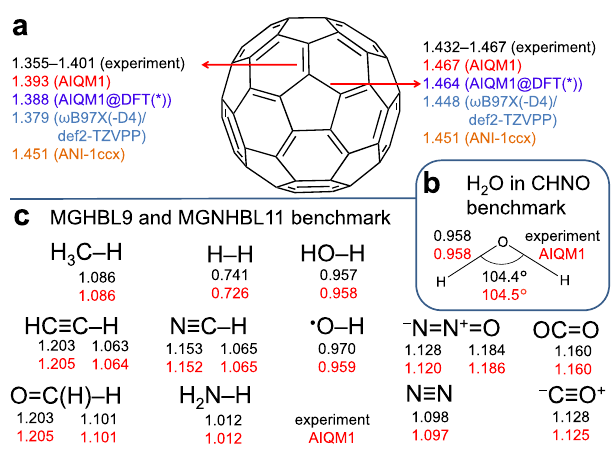
Fig. 6 Performance of the arti fi cial intelligence – quantum mechanical method 1 (AIQM1) for fi nding ground-state minimum geometries. a Short and long bond lengths in C 60 as calculated at different levels of theory and compared to experimental values 46 – 49 . Note that geometries of C 60 are the same at both AIQM1@DFT and AIQM1@DFT* as well as at both ω B97X and ω B97X-D4/def2-TZVPP. b All hydrogenic bond lengths in the MGHBL9 data set 50 and non-hydrogenic bond lengths in the MGNHBL11 data set 50, 51 . c Geometry of a water molecule (one of the molecules in the CHNO benchmark; note that experimental reference is slightly different from that in MGHBL9 set in panel b ) 37 . Bond lengths are in Å. Experimental values in black, AIQM1 values in red, other methods marked with other